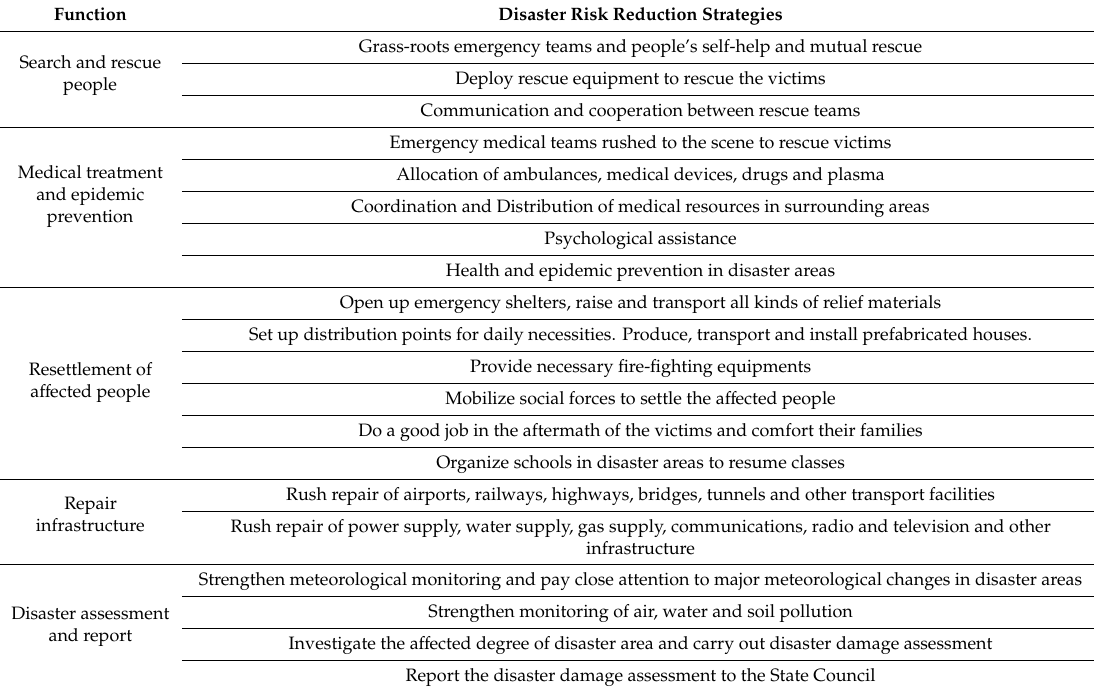
Table 5. Disaster risk reduction strategies and corresponding social organizations’ functions.